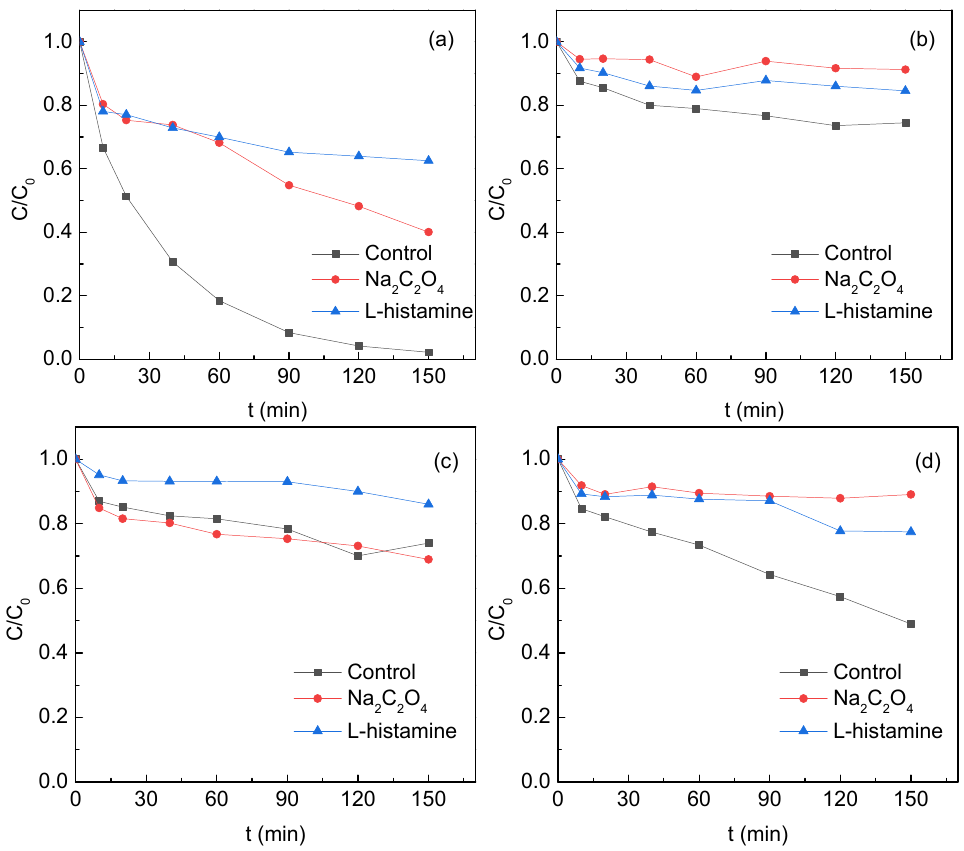
Figure 8. Influence of Na 2 C 2 O 4 and L-histamine on SMT removal ( a ) S1, ( b ) S2, ( c ) S3 and ( d ) S4. Reaction conditions: [SMT] 0 = 5 mg/L, [PS] 0 = 4 mM, [TM] 0 = 5 g/L, pH 0 = 5 and T = 25 ◦ C. ( a ) was drawn with modification after Zhang et al.